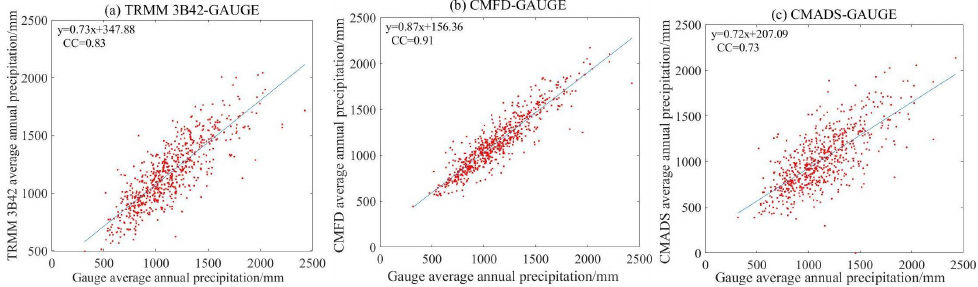
Figure 3. Scatterplot of three precipitation products and station-measured annual precipitation.